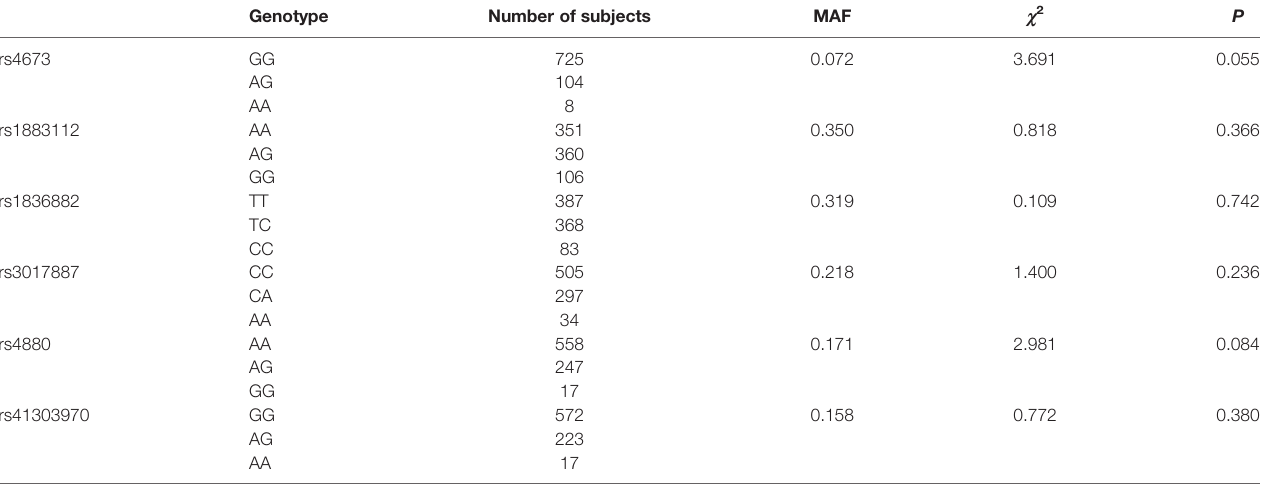
TABLE 2 | Test of Hardy-Weinberg Equilibrium for the six single-nucleotide polymorphisms in healthy